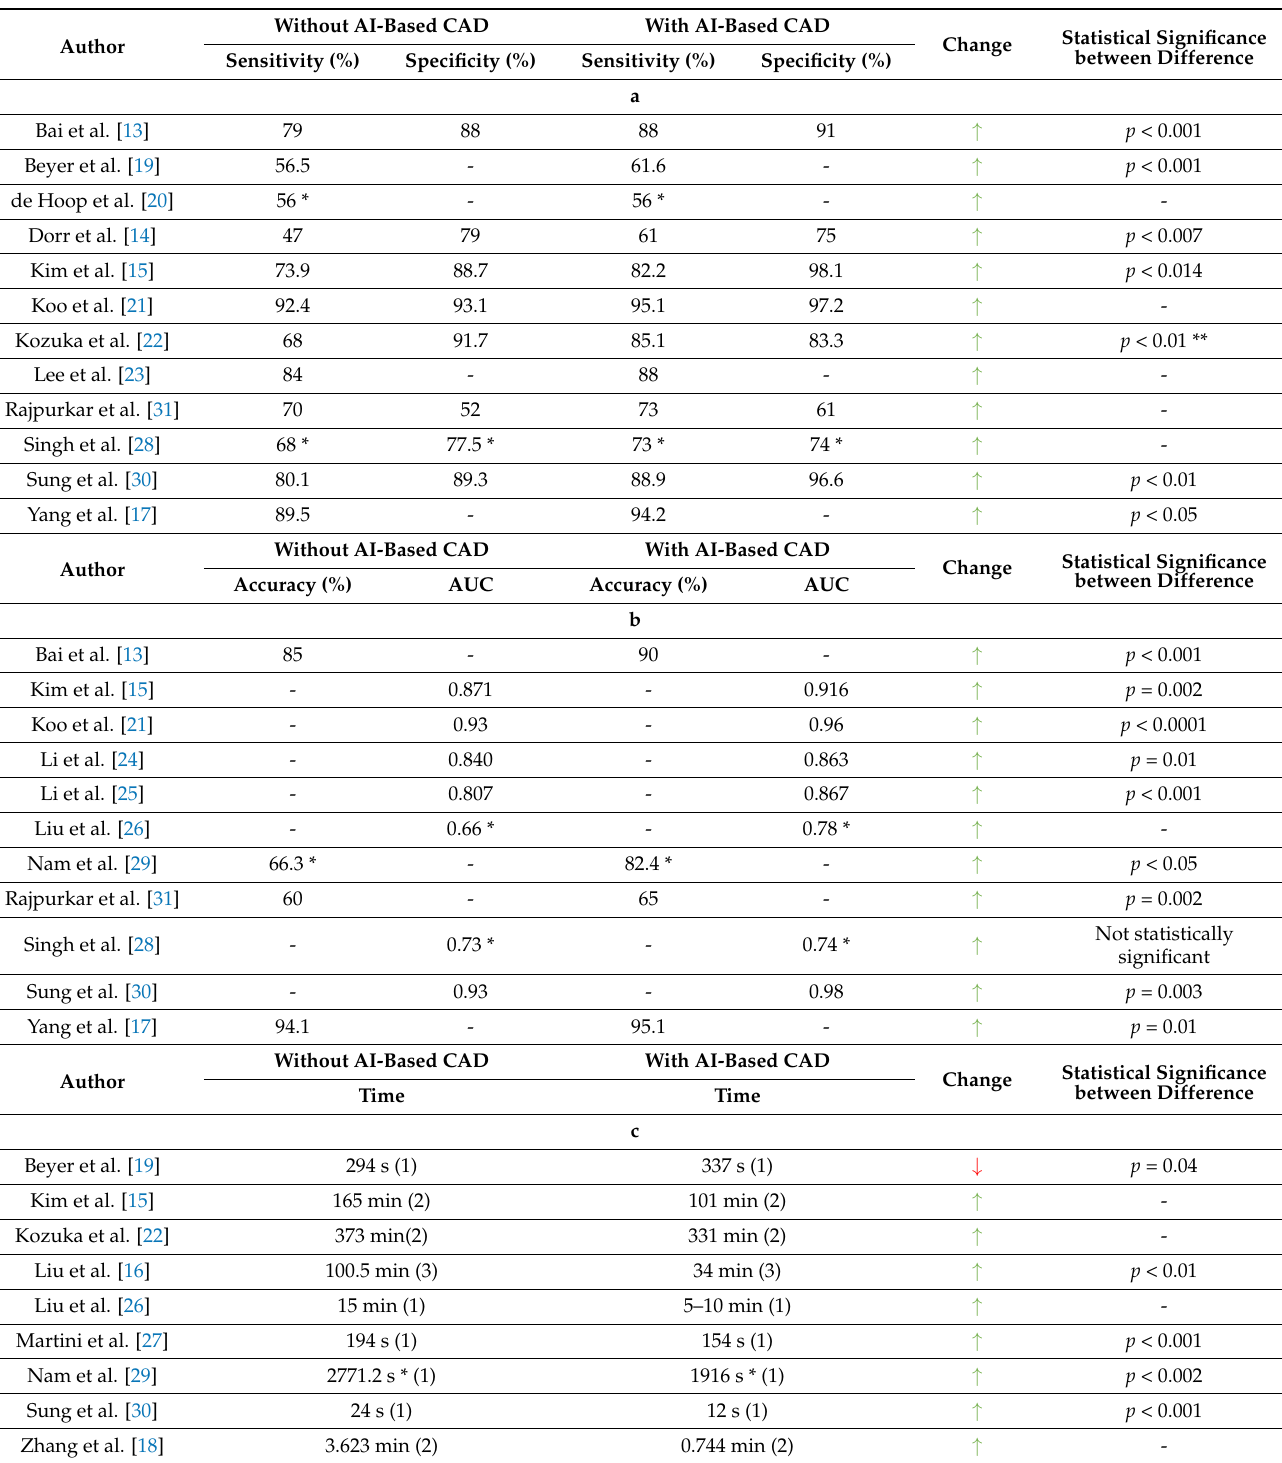
Table 2. Sensitivity and specificity ( a ); accuracy and AUC ( b ); and time measurement results ( c ) for observer tests without and with AI-based devices as a concurrent